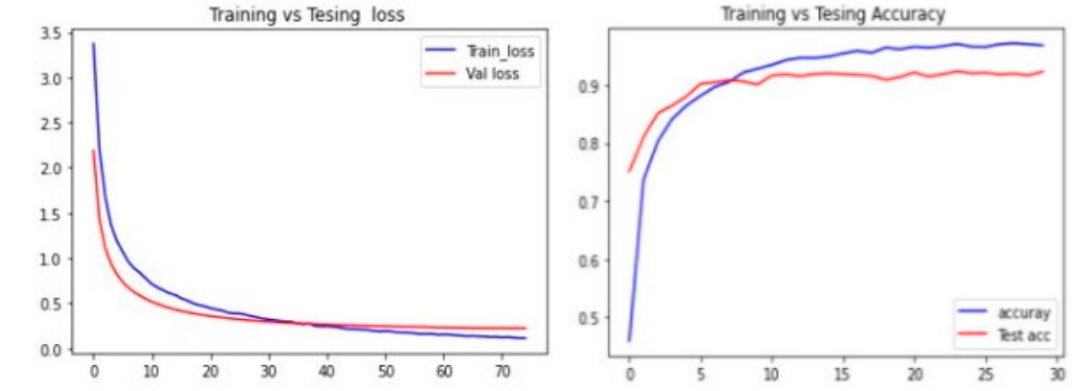
Figure 13. Confusion matrix for convolutional neural network.